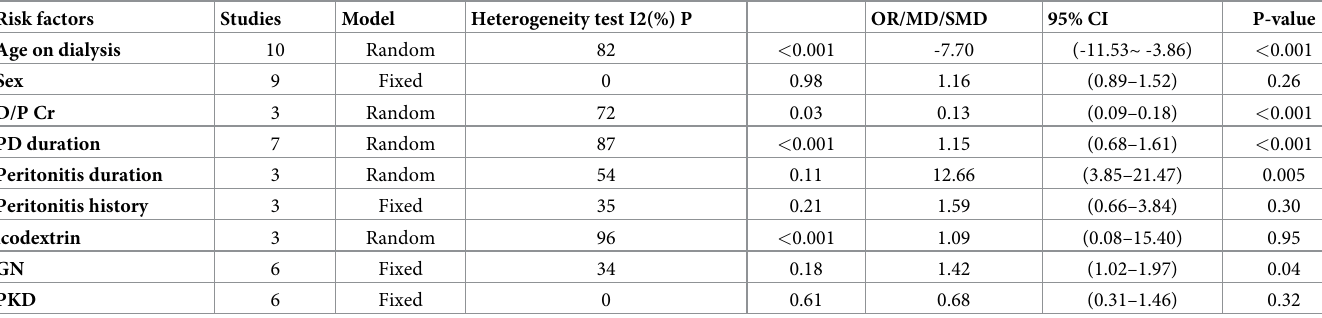
Table 2. Meta-analysis of the pooled risk factors for